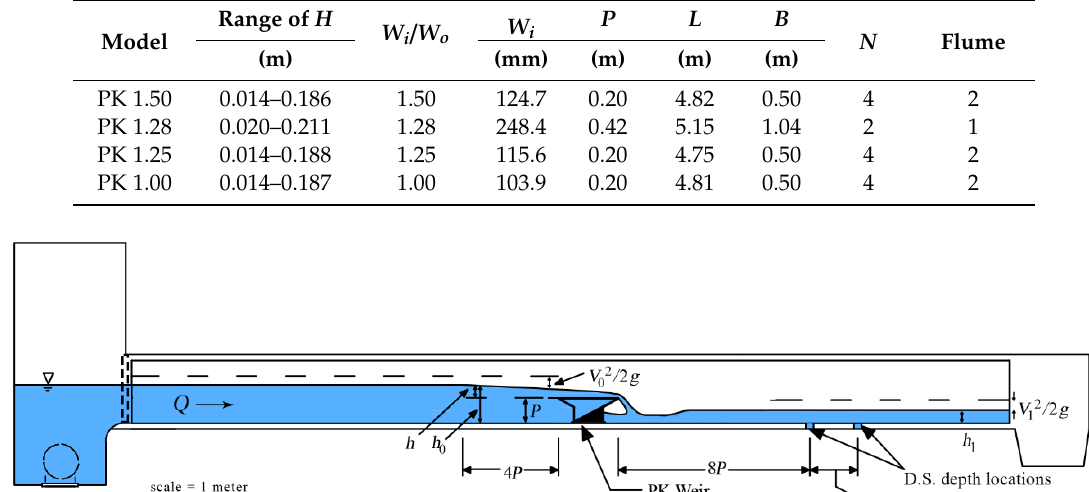
Figure 2. Geometric overview of PK weir geometries investigated herein. Table 1. Type A PK weir energy dissipation model summary. Table 1. Type A PK weir energy dissipation model summary.